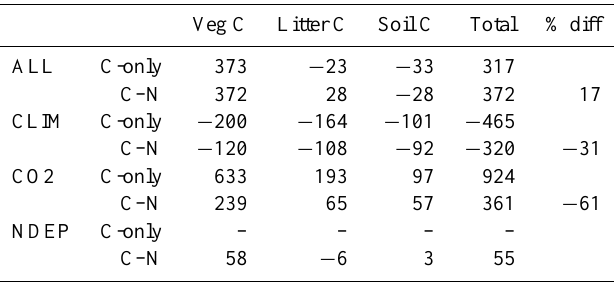
Table A1. Modelled C sequestration between 1850 to 2100 [PgC] for climate change (CLIM), atmospheric [CO 2 ] (CO2), N deposition (NDEP) alone, and all together (ALL).